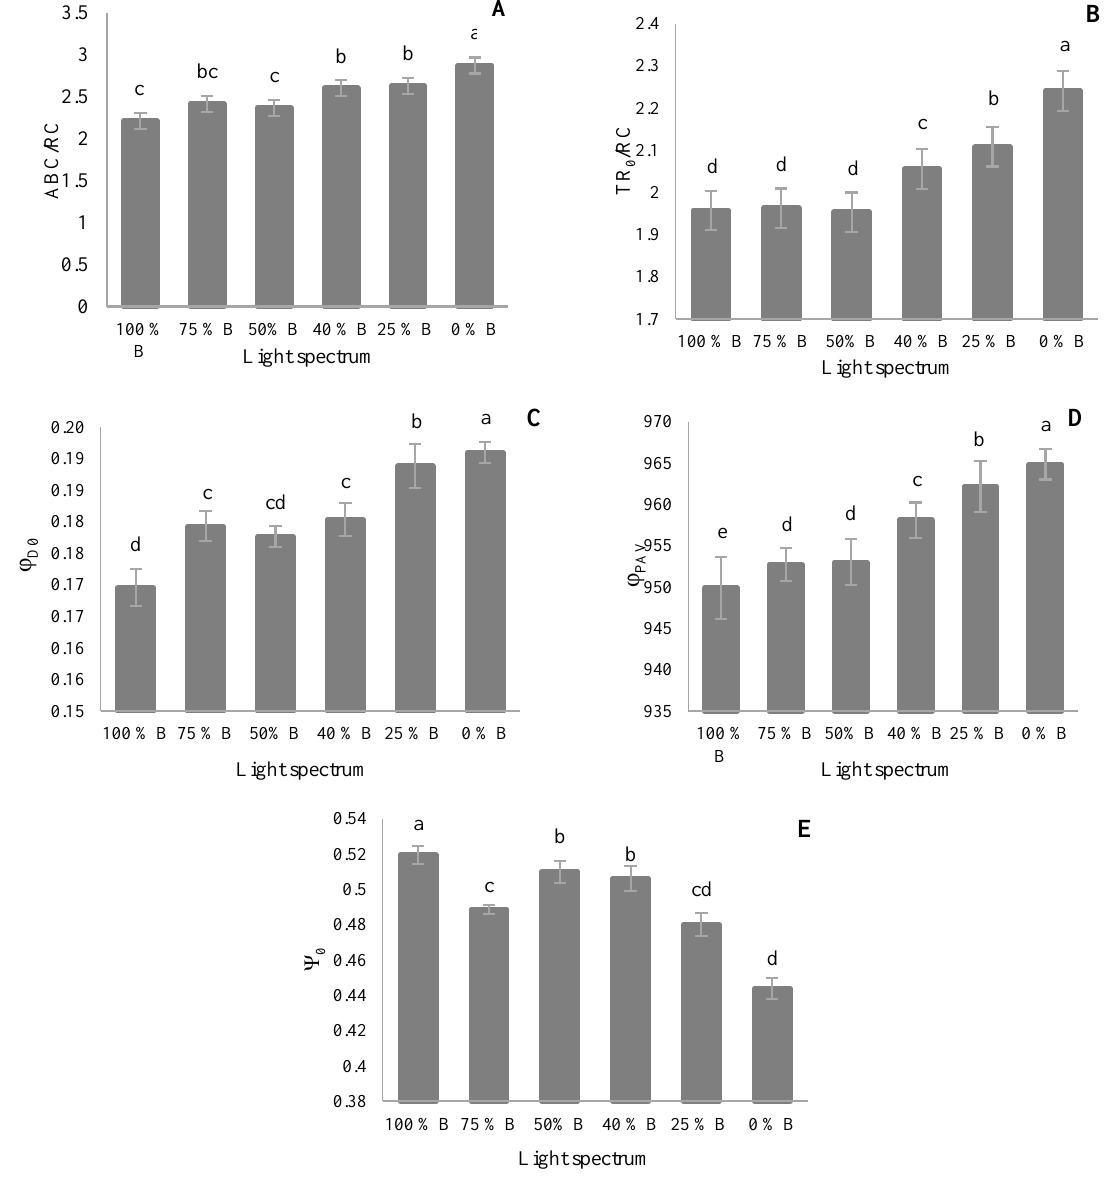
Figure 6. Specific energy fluxes per reaction center (RC) for energy absorption ( A ; (ABS/RC)), trapped energy flux ( B ; (TR 0 /RC)), electron transport flux ( C ; (ET 0 /RC)), and dissipated energy flux ( D ; (DI 0 /RC); equations in Table 1) of saffron plants grown under different ratios of Blue ( E ) light in the overall spectral composition, including 100% B, 75% B, 50% B, 40% B, 25% B, 0% B (see the spectrum in Figure 1), with 150 ± 10 μmol m −2 s −1 PPFD. Different letters indicate that values are significantly different at p < 0.01 according to Duncan’s multiple range tests. Bars represent mean value ± standard deviation .